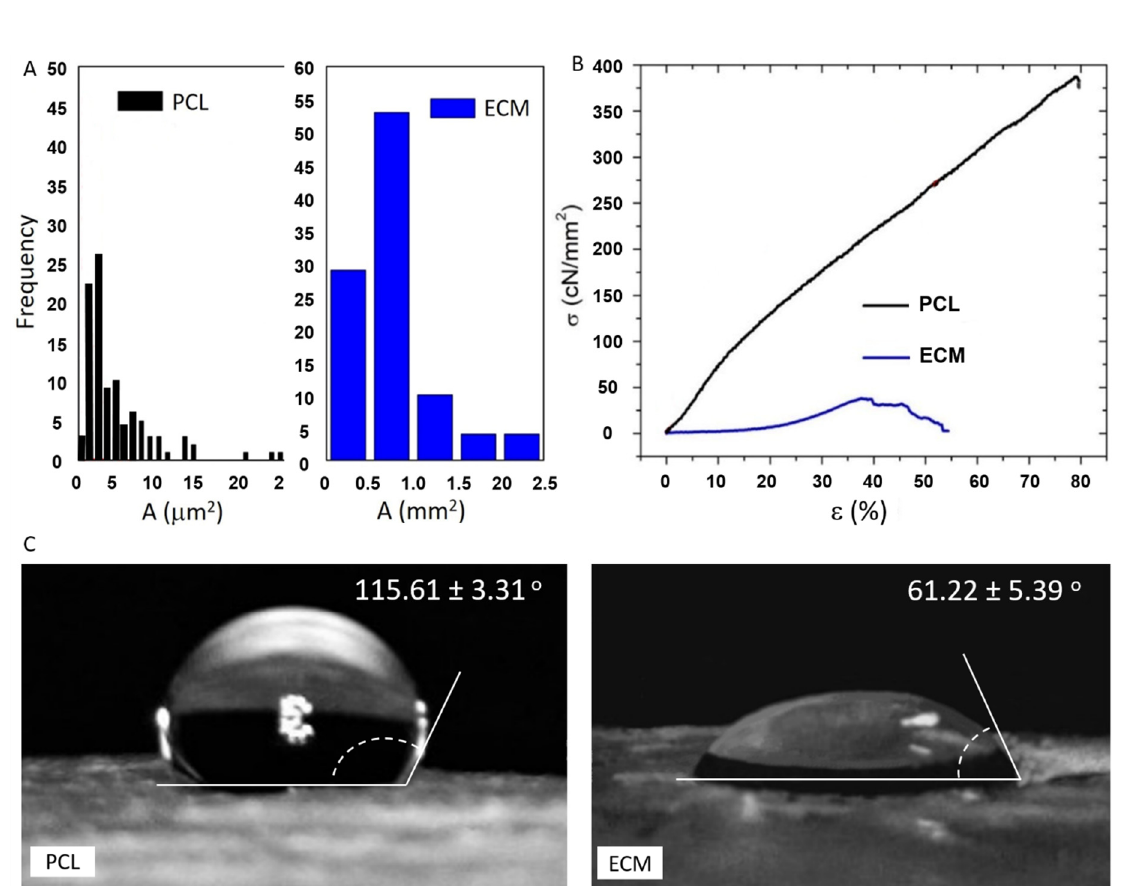
Table 1. Structural and physical properties of assessed poly( ε -caprolactone) (PCL) and extracellular matrix (ECM) scaffolds: mean fiber diameter ( d fibre ), mean pore area ( A pore ), mean sample weight ( m ), mean sample thickness ( h ), polymer density ( ρ ), total porosity ( p ), maximum load ( F ), strain ( ε ) and tensile strength ( σ ). Scaffold Figure 1. Scaffold samples prepared for comparative bioactivity assessment: electrospun PCL mat and porcine liver ECM. In the lower row are images of the scaffolds taken by SEM.